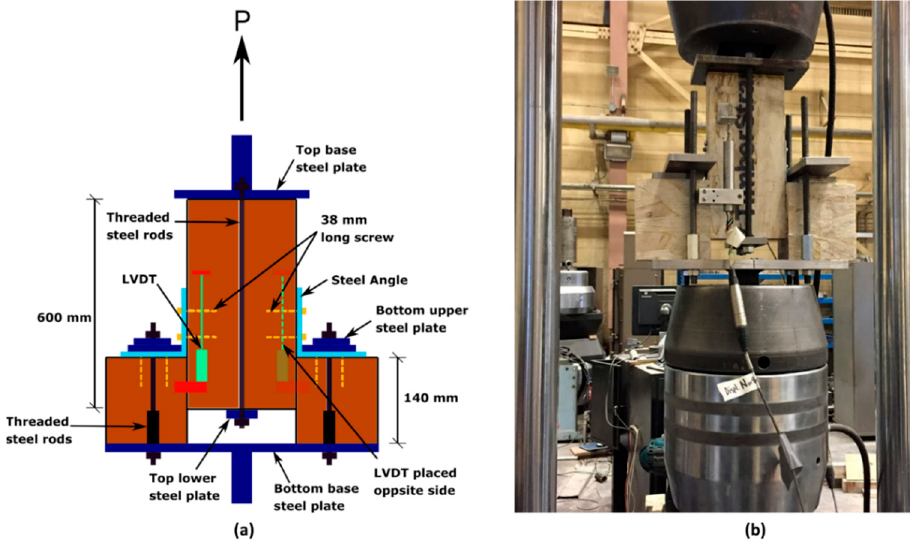
Figure 16. Connection-F test setup: ( a ) schematics; ( b ) actual image.